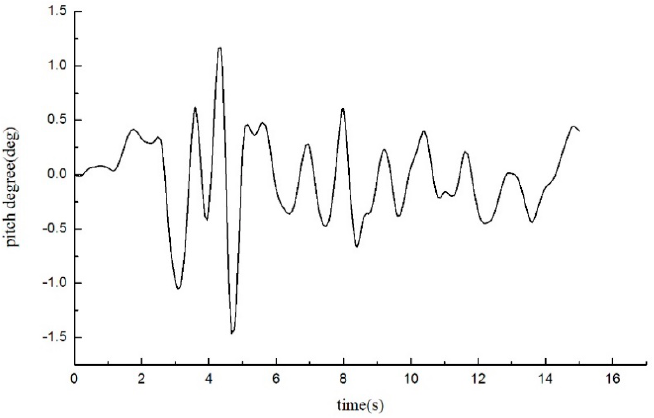
Figure 16. Roll curve of the ship in case 7.